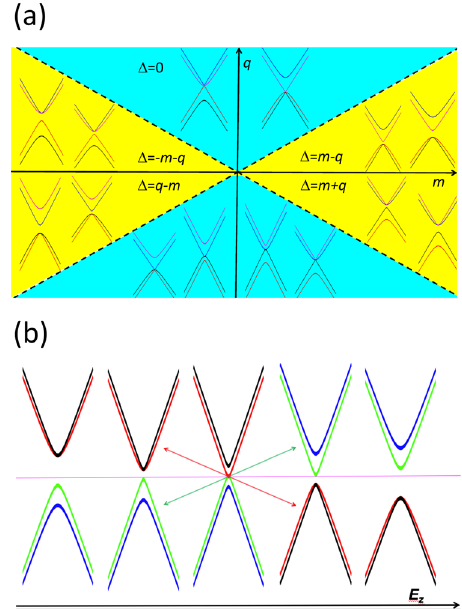
Fig. 3 Topological phase space and transition in the k ⋅ p-model. a Topology of the model described by the Hamiltonian, Eq. (8) as a function of parameters m and q . The zero gap ( Δ = 0) region is indicated in cyan, while the range of parameters giving a gapped band structure are marked in yellow. b An example of electronic band structure derived from the model Hamiltonian, Eq. (8) and from the eigenvalues of this Hamiltonian, presented by the Eqs. (1) for a small, constant value of q . The application of an electric fi eld above a certain critical value can switch a hole band to an electron band (and vice versa).